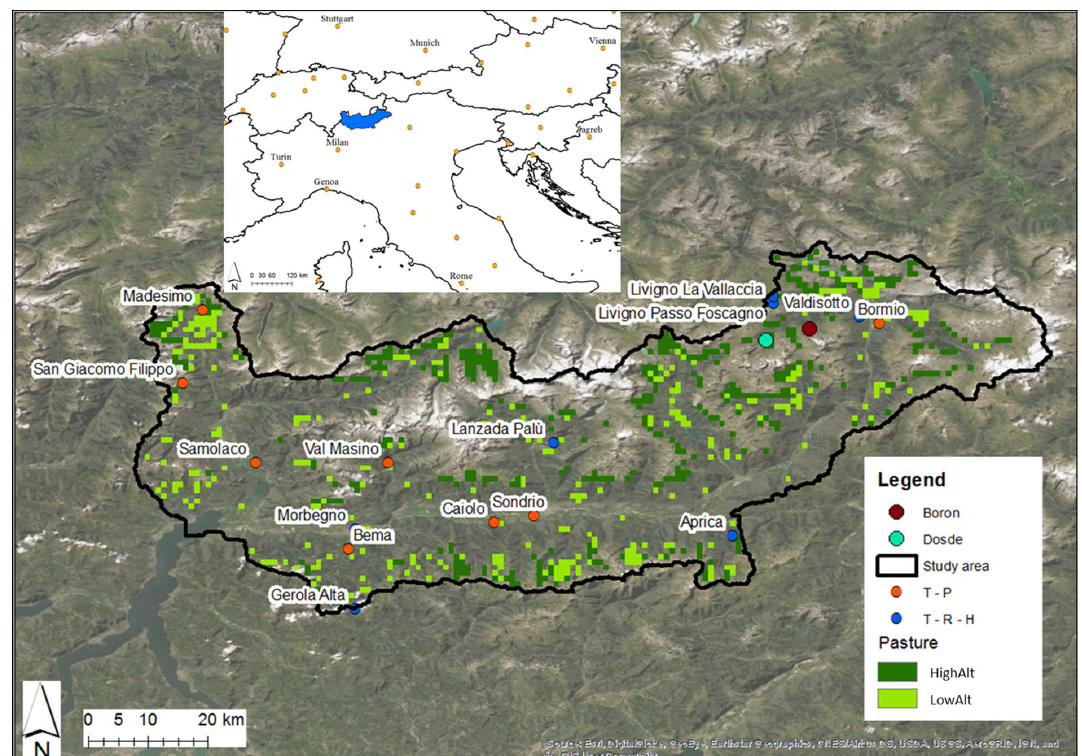
Figure 1. Map of the study area: location of two experimental sites of Boron (dark red) and Dosdè (light blue) and of automatic weather stations AWS (orange stations (T-P) provide temperature and total precipitation, blue stations (T-R-H) provide temperature, rain (liquid precipitation) and snow depth). The pasture area, identified from a Corine Land Cover map (CLC, 2012), is reported as per altitude belts HighAlt (>2000 m asl) and LowAlt (<2000 m asl). In the white map, the geographic location of Valtellina and Valchiavenna within the Alpine belt is shown.